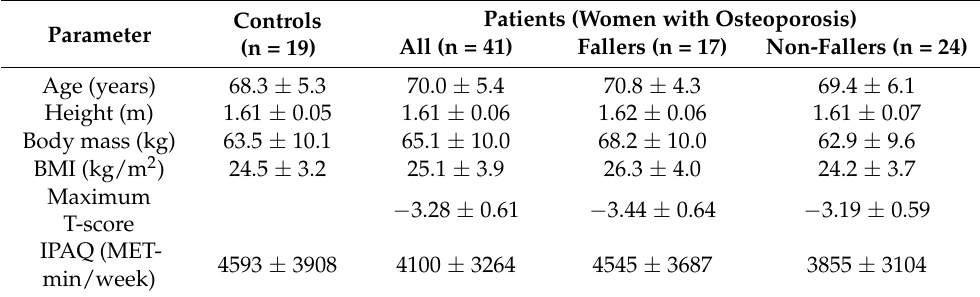
Table 1. Mean ± standard deviation for anthropometric parameters, T-score, and physical activity for controls and patients (women with osteoporosis), as well as for osteoporotic women with (fallers) and without (non-fallers) a fall